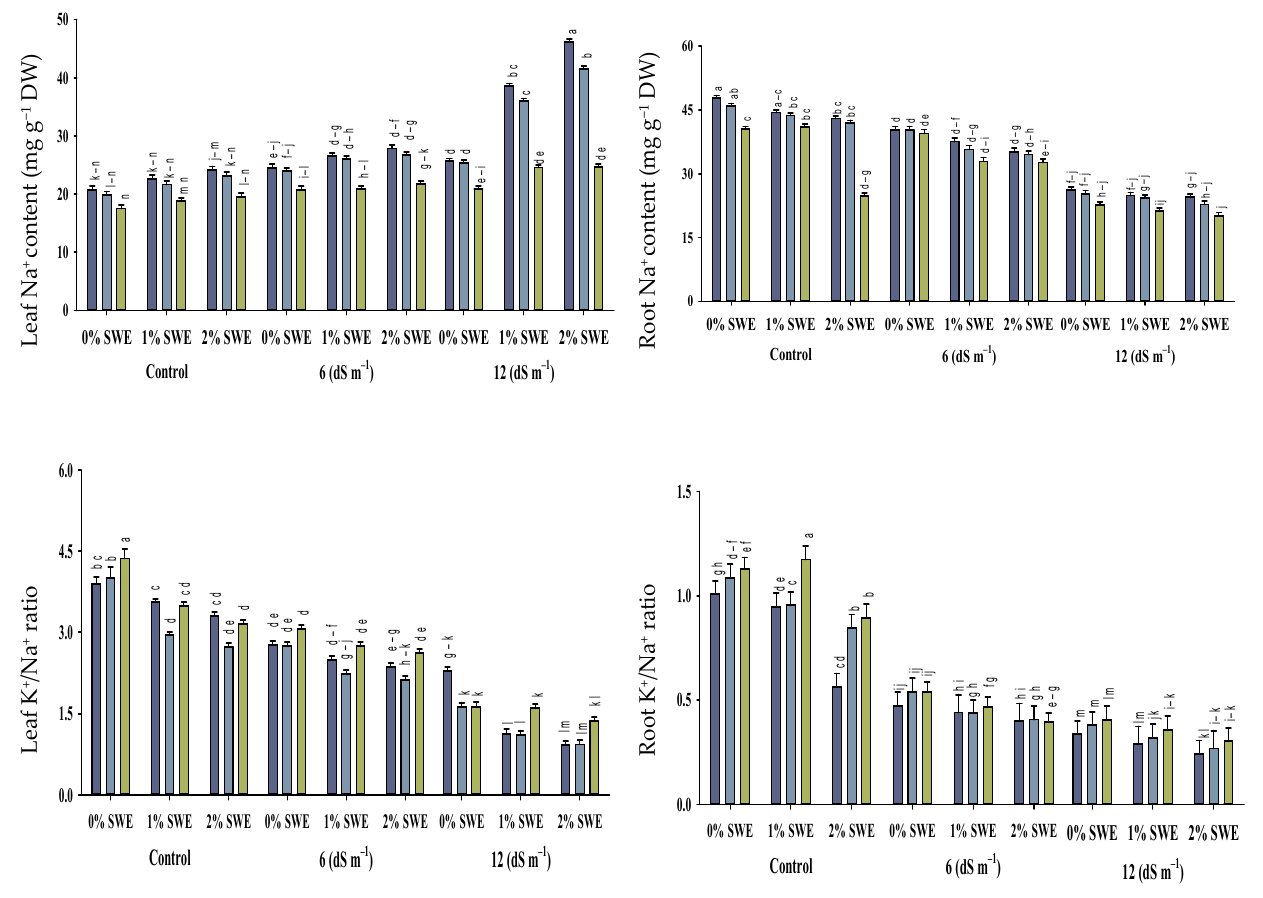
Figure 5. Sodium (Na + ) and potassium ion (K + ) contents and K + /Na + ratio of maize as affected by various treatments of vermicompost (VC), sorghum water extract (SWE) under control, moderate salinity (6 dS m − 1 ), and high salinity (12 dS m − 1 ). Bars with the same letters do not differ significantly ( p ≤ 0.05).